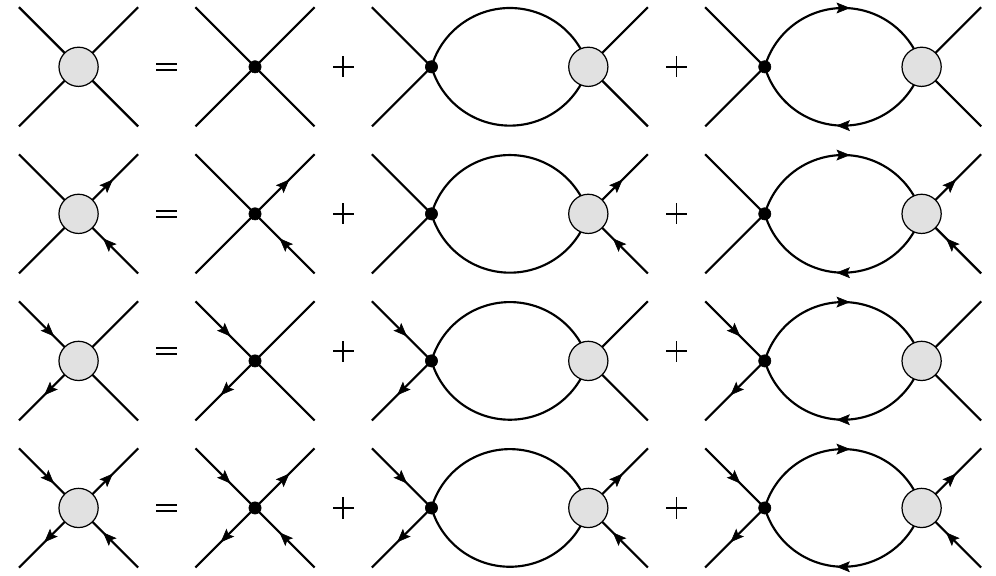
Figure 20 . Diagrammatic representation of the coupled-channel Lippmann-Schwinger integral equations for the transition amplitudes A 00 ( E ), A 01 ( E ), A 10 ( E ), and A 11 ( E